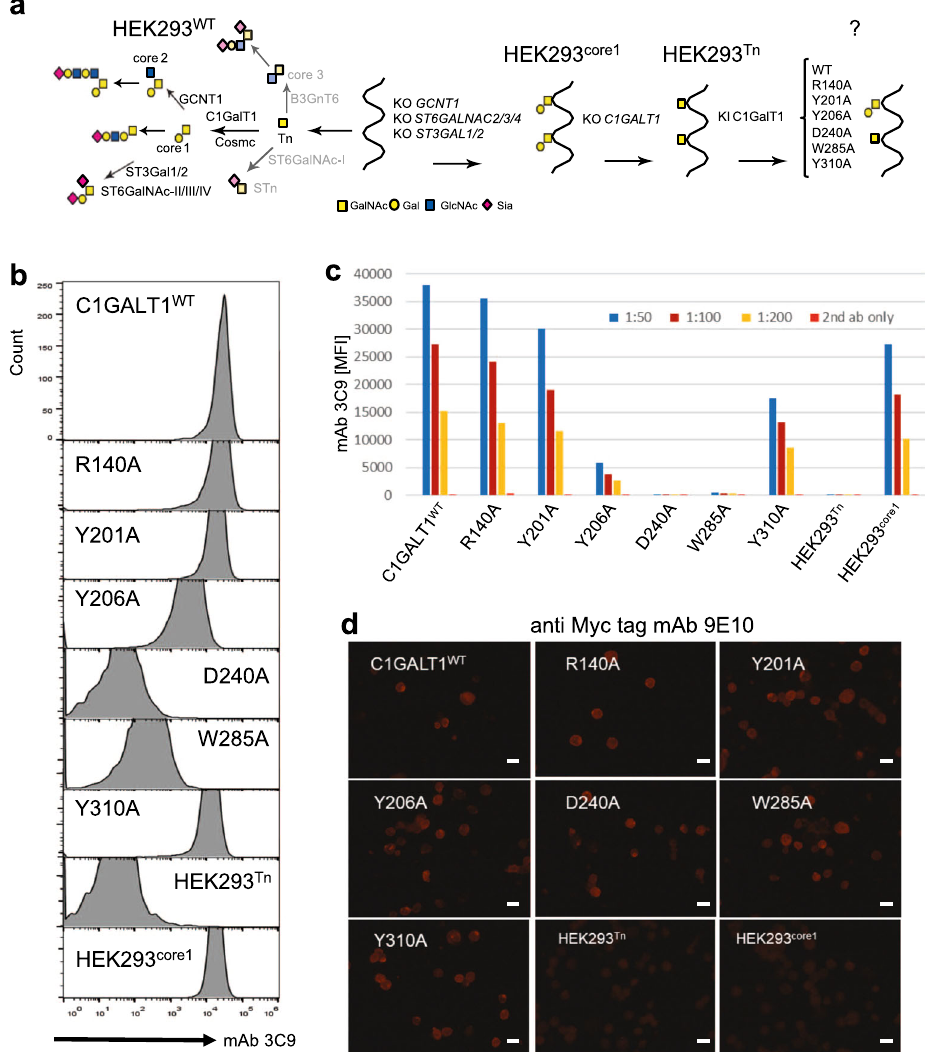
Fig. 5 Flow Cytometry Analysis of the reinstallation of T glycoform with Hs C1GalT1 mutants. a The O -glycosylation pathway is indicated with the name of the enzymes involved in the synthesis of O -glycan structures. Note that the non-expressed genes and the predicted basic glycan features missing in HEK293 cells are faded out based on RNA-seq analysis. The engineering strategy to develop HEK293 Tn clone was performed with C1GALT1 gene KO in HEK293 core1 cells (HEK293 KO GCNT1,ST3GAL1/2,ST6GALNAC2/3/4 ) followed by the individual KI of C-terminal Myc tagged Hs C1GalT1 WT and 6 mutants complementary DNA. b Flow cytometry analysis with the core 1 speci fi c monoclonal antibody 3C9 (1 to 100 diluted hybridoma supernatant) were used to evaluate the cell surface level of T or core 1 glycoform. c Bar diagrams show mean fl uorescence intensities of the mAb 3C9 binding. d Immunocytology analysis of single KI clones with anti-Myc-tag mAb 9E10 detecting C-terminal Myc tag of C1GalT1. Note that HEK293 core1 clone (HEK293 KO GCNT1,ST3GAL1/2,ST6GALNAC2/3/4 ) has endogenous expression of Hs C1GalT1 without Myc tag. Images are representative of three experiments ( n = 3 independent experiments). Scale bar = 20 μ